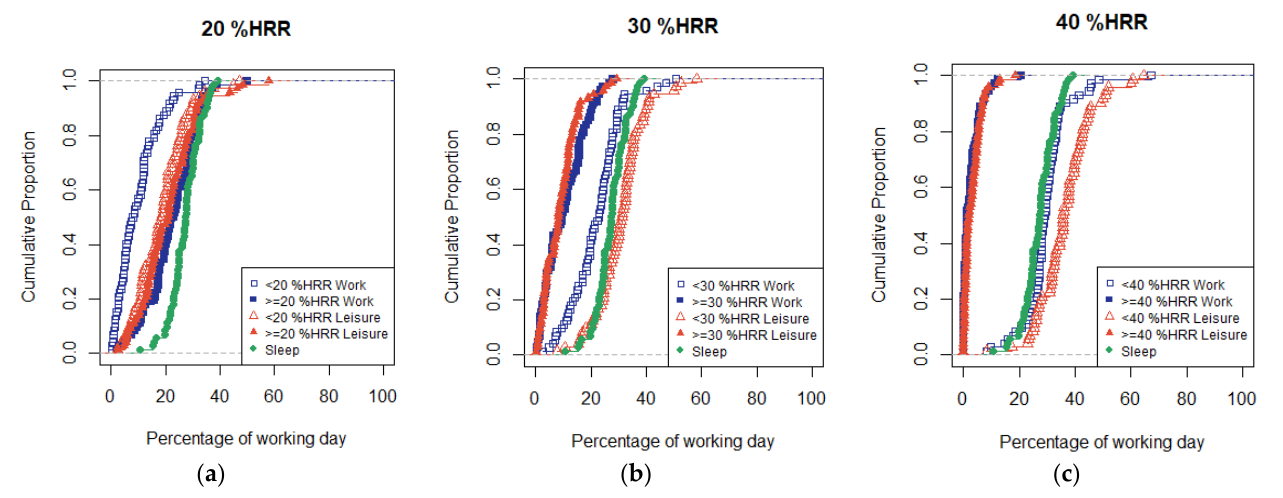
The main variable is in bold.